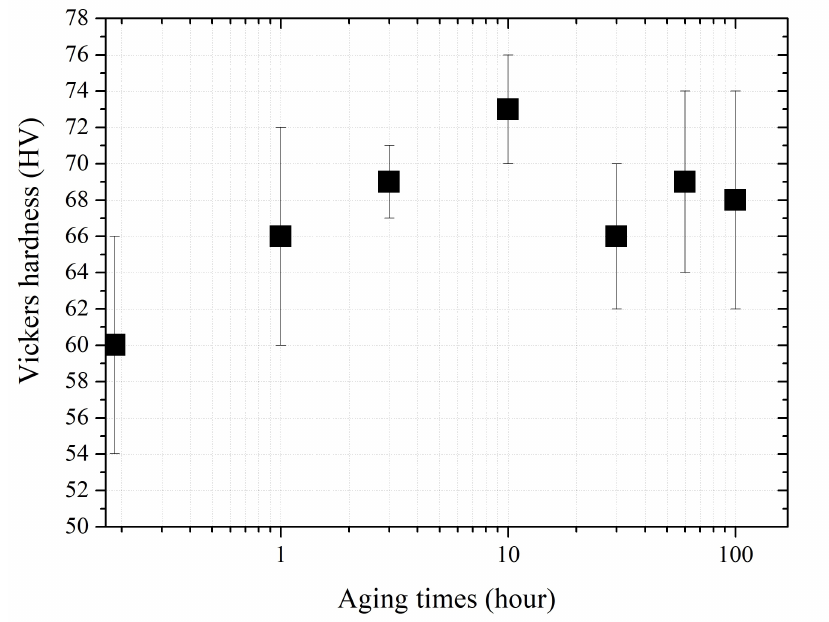
Figure 4. Aging hardening behavior at 250 ◦ C after hot